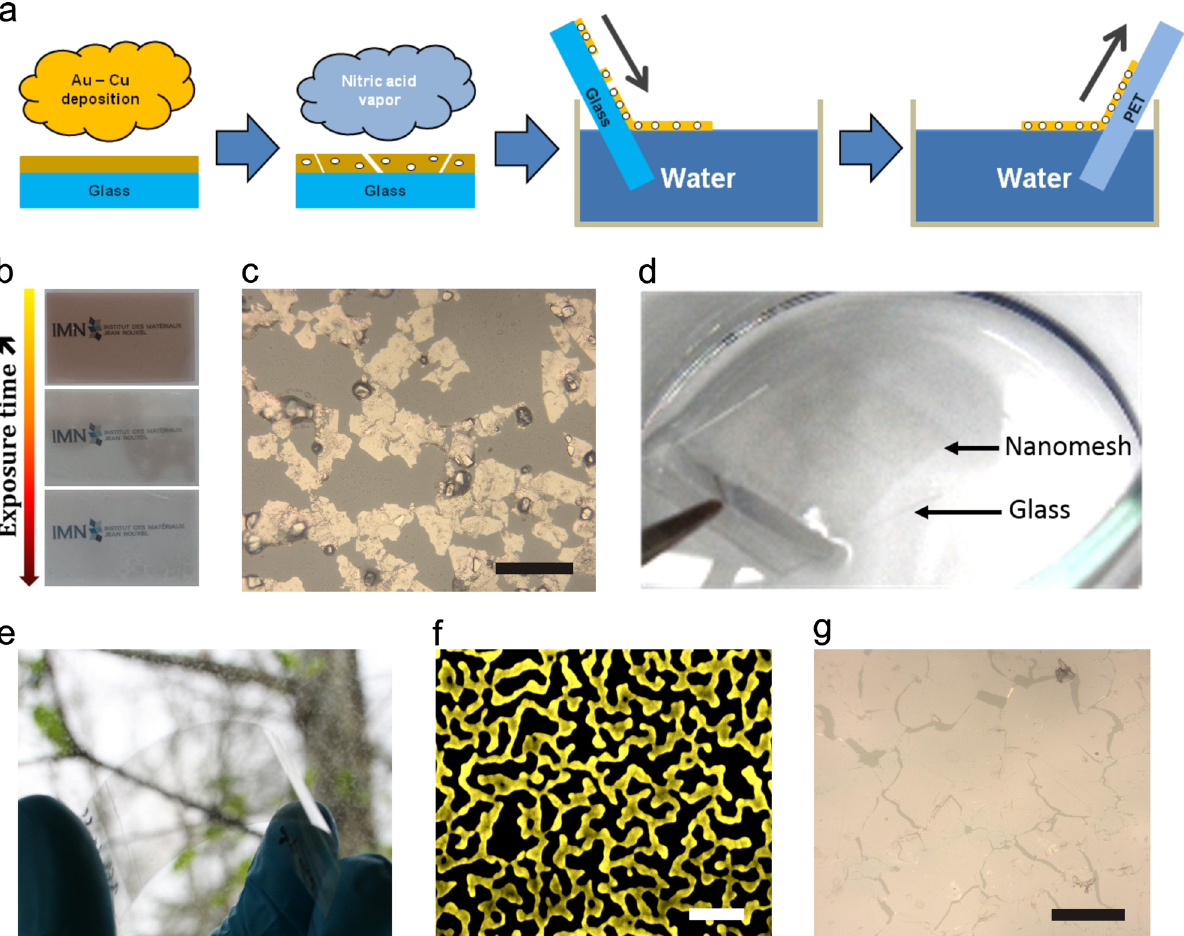
Fig. 1 Fabrication and transfer of the highly fl exible gold nanomesh electrode. a Schematic showing the different steps of the approach used to fabricate the gold nanomesh electrode. Au-Cu ultra-thin fi lm is fi rst deposited by magnetron co-sputtering on a glass substrate. The alloy is then exposed to nitric acid vapors before transfer to a target fl exible substrate (e.g., PET). b Photographs showing the evolution of the Au-Cu fi lm as a function of exposure time to nitric acidic vapors. c Optical microscope images of micropatches constituted of gold nanomesh on a glass substrate for a sample with 23 at.% of gold and 10 nm at initial state before transfer. d Photograph showing a gold nanomesh fl oating on the surface of distilled water and ready for the transfer onto a fl exible substrate. e Photograph of a gold nanomesh on a PET substrate. f Top- view false-colors SEM image of a gold nanomesh prepared using Au-Cu fi lm with an initial Au content of 17 at.% and a thickness of 10 nm. g Optical microscope images of a gold nanomesh on a glass substrate for a sample with 23 at.% of gold and 10 nm at initial state after transfer. White scale bar: 200 nm. Black scale bar: 100